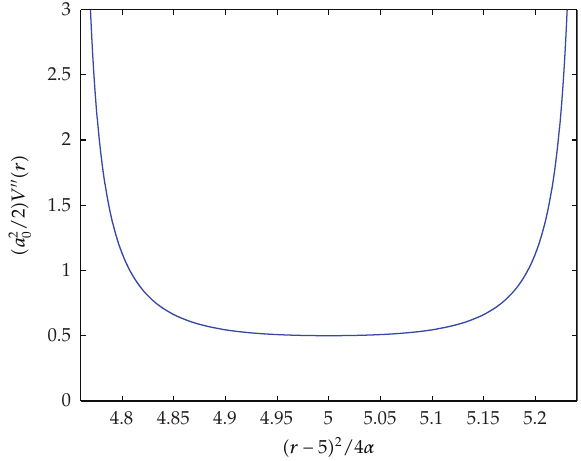
Figure 1: The Schwarzschild wormhole: V (cid:7)(cid:7) > 0 near r (cid:5) a 0 .